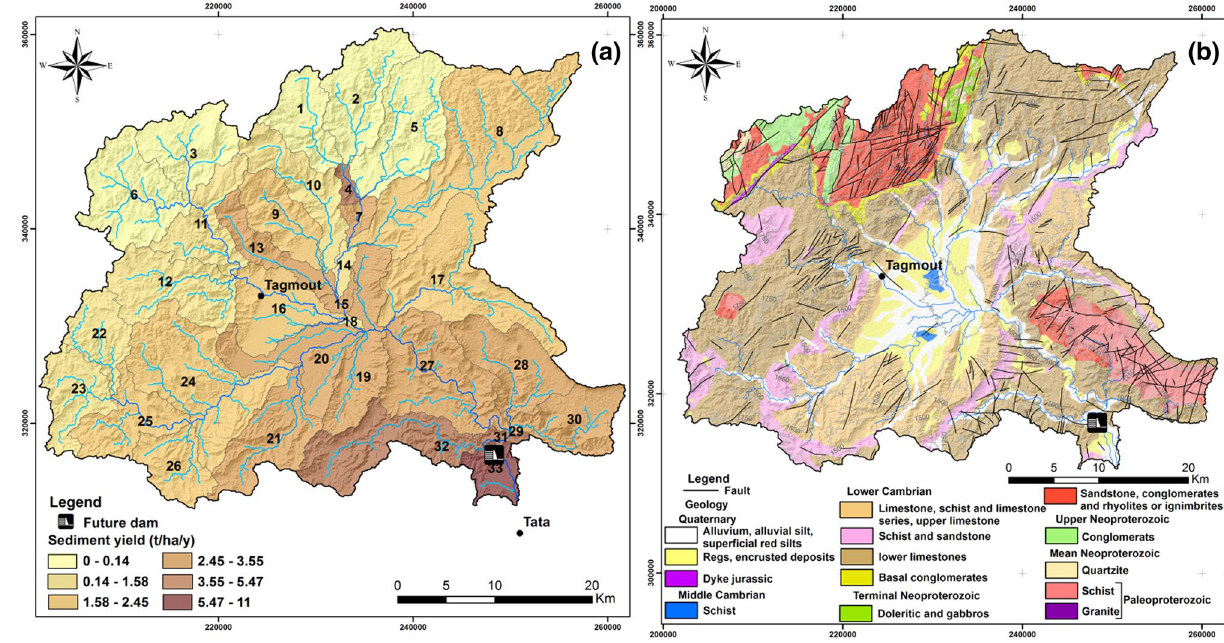
Fig. 7 a Distribution of Sediment yield of the Tata basin b Geological map of Tata